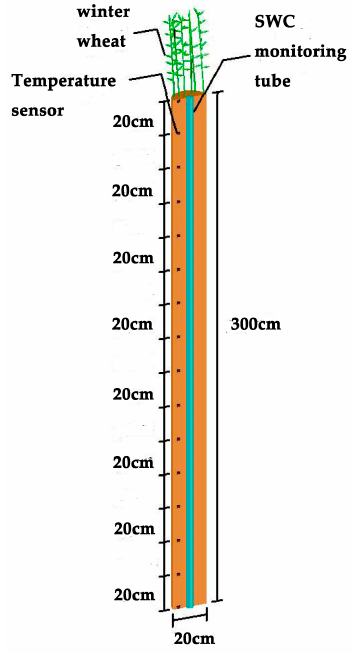
Figure 2. Test equipment.